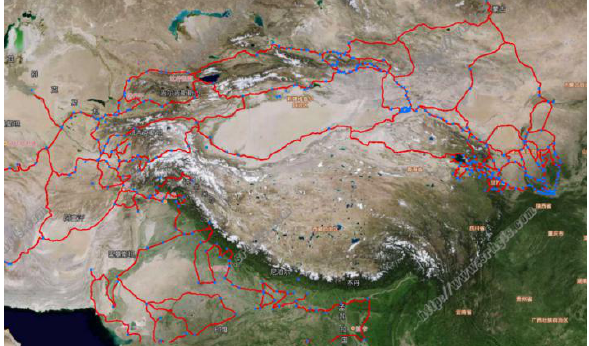
Figure 1. Routes to the Tibetan Plateau are excluded from Routes of the Silk Road (Tang Dynasty) (source: Silk Road Historical Geography Information Open